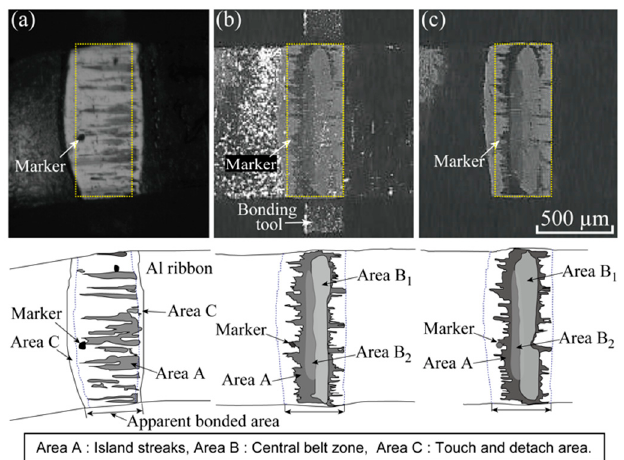
Figure 6. Comparison between video capture and two still images. The bonding condition is F b = 7 N and P u = 3 W: ( a ) Video capture at t = 400 ms taken at shutter speed of 5 µs; ( b ) Still image of bonded interface taken under bright illumination (light emitting diode (LED) ring lights + laser pointer); ( c ) Still image taken under dark illumination (only the LED lamps).